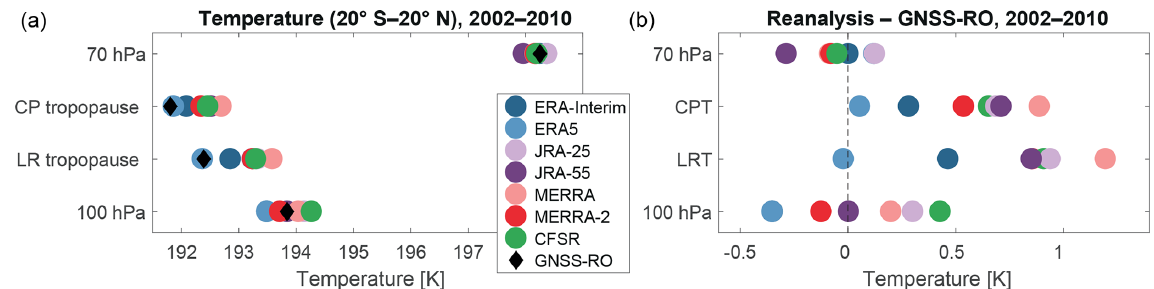
Figure 3. Tropical mean (20 ◦ S–20 ◦ N) temperatures at 100hPa, the lapse rate tropopause (LRT), the cold point tropopause (CPT), and 70hPa from reanalyses and GNSS-RO data during 2002–2010 (a) . Differences between the GNSS-RO and reanalysis temperatures are shown in panel (b) . At 100hPa, ERA-Interim is hidden by ERA-5; at the LRT, MERRA-2 is hidden by JRA-55; and at 70hPa, ERA5 is hidden by JRA-25 and MERRA is hidden by MERRA-2.